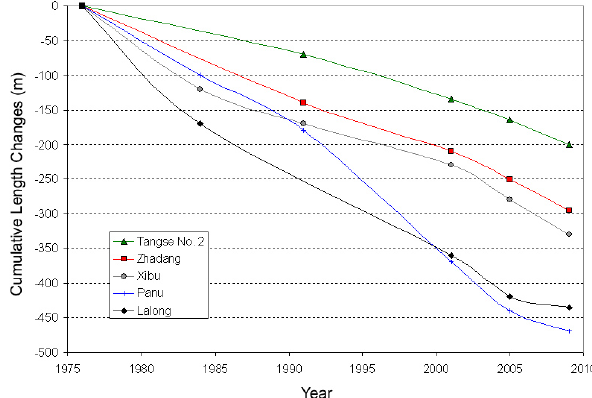
Fig. 9. Cumulative length change of the five glaciers studied in